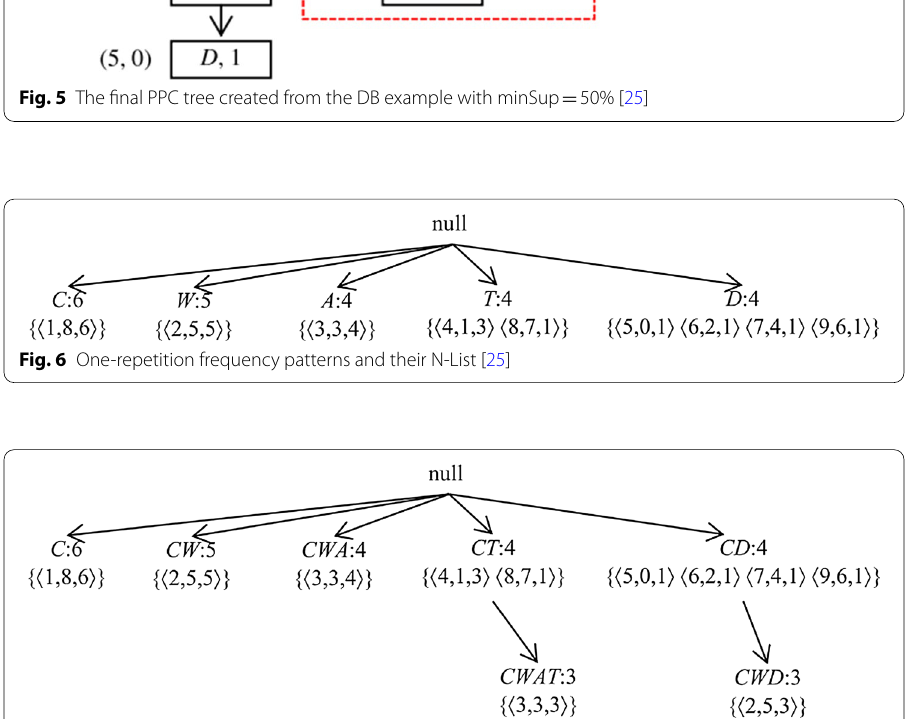
Fig. 7 An example of the N-List algorithm for exploring repetitive transactions